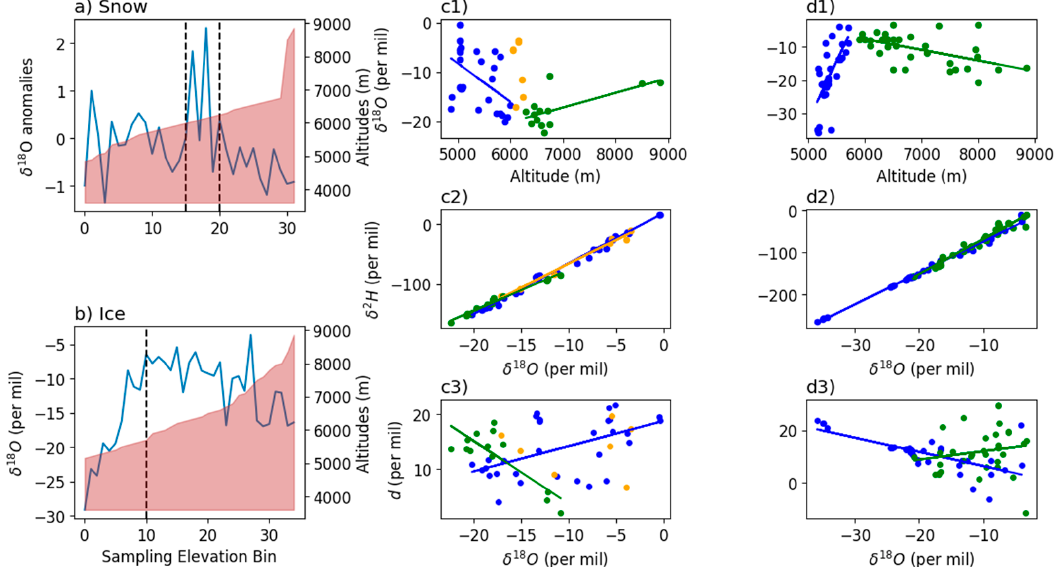
Figure 6. Possible transition in the snow/ice δ 18 O variations with altitude in the Southern Himalaya identified using change point detection. ( a ) transitional zone detected for surface-snow samples, and ( b ) same as ( a ), but for ice samples. ( c1 – c3 ) vertical lapse rate of δ 18 O in surface-snow samples with altitude, local evaporation lines (LELs) and correlation of δ 18 O with d excesses in different elevation ranges; least square linear regression lines are shown, together with corresponding results for significant correlations at 95% confidence level. ( d1 – d3 ) same as ( c1 – c3 ), but for ice samples. The brown shadings in ( a , b ) indicate samples’ elevations. ‘Trans-‘ and ‘Trans + ’ indicate areas, respectively, below and above the transition. Blue, orange, and green dots in ( c )s and ( d )s indicate samples, respectively, below, within, and above the transitional zone.